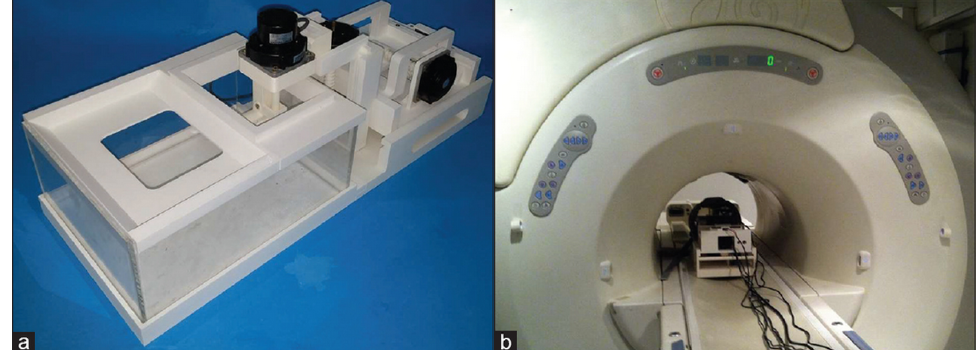
Figure 12. ( a ) MRI-guided system for focused ultrasound ablation in companion animals by Dami- anou et al. [65]. ( b ) Device located at the isocenter of the MRI